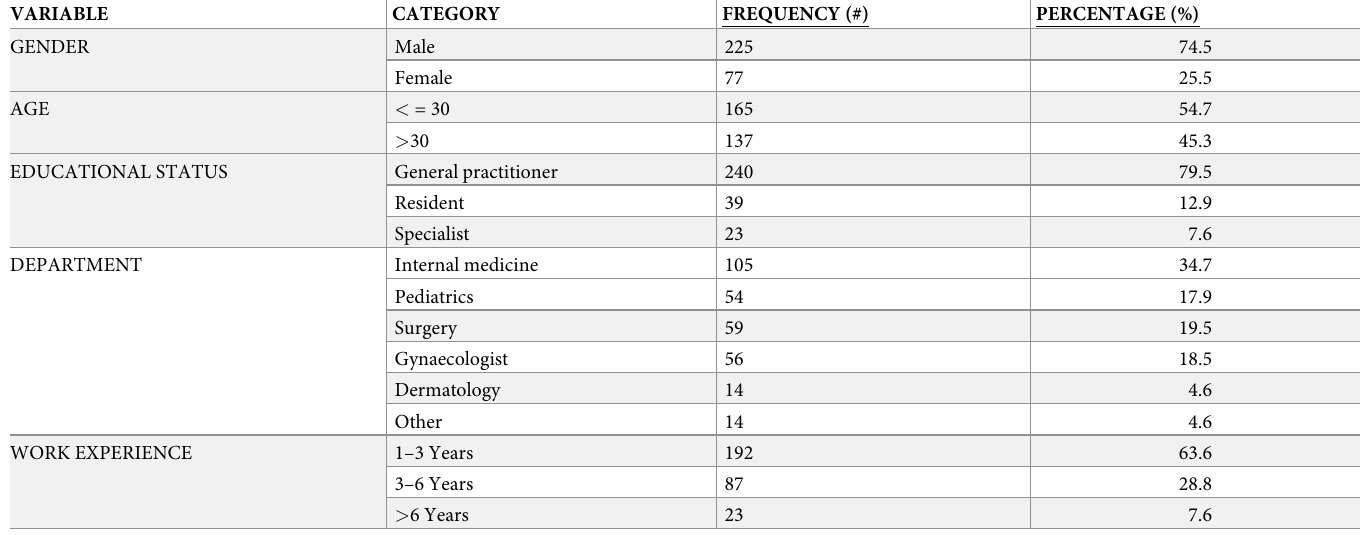
Table 1. Sociodemographic characteristics of participants (n =